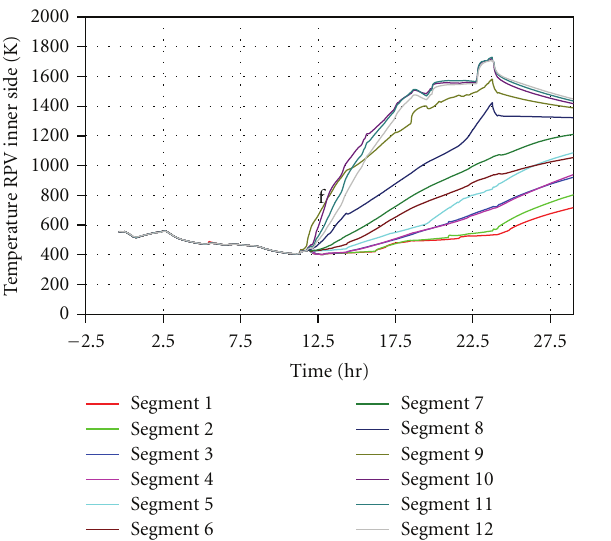
Figure 25: Temperature of RPV bottom wall at outer